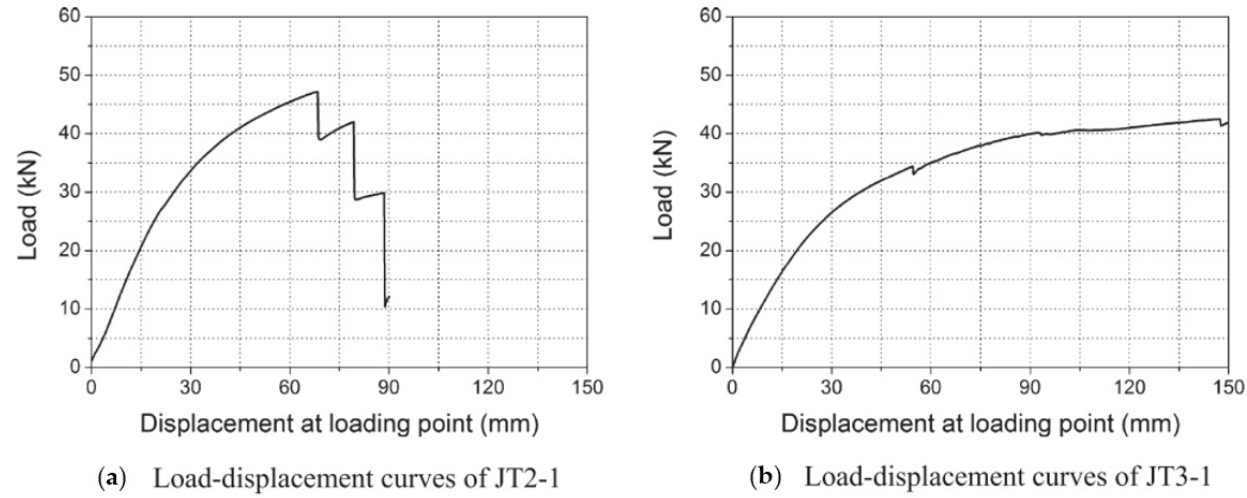
Figure 22. Load-displacement curves for specimens ( a ) JT2-1 ( b ) JT3-1 under monotonic tests, adapted from [55].